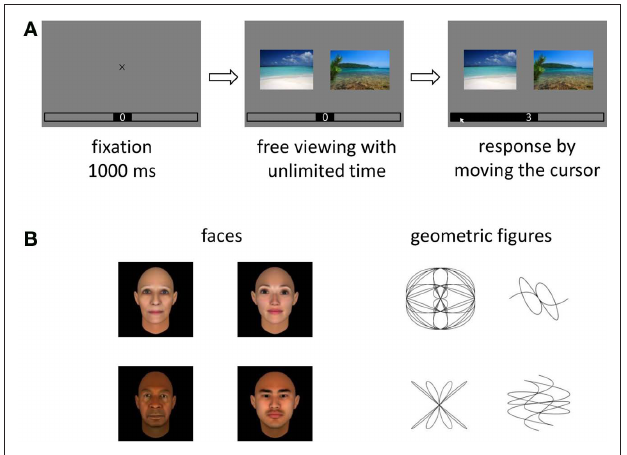
Figure 1 | Stimuli and procedure. (A) Sample judgment phase trial with natural scene images. (B) Examples of face and geometric figure images.